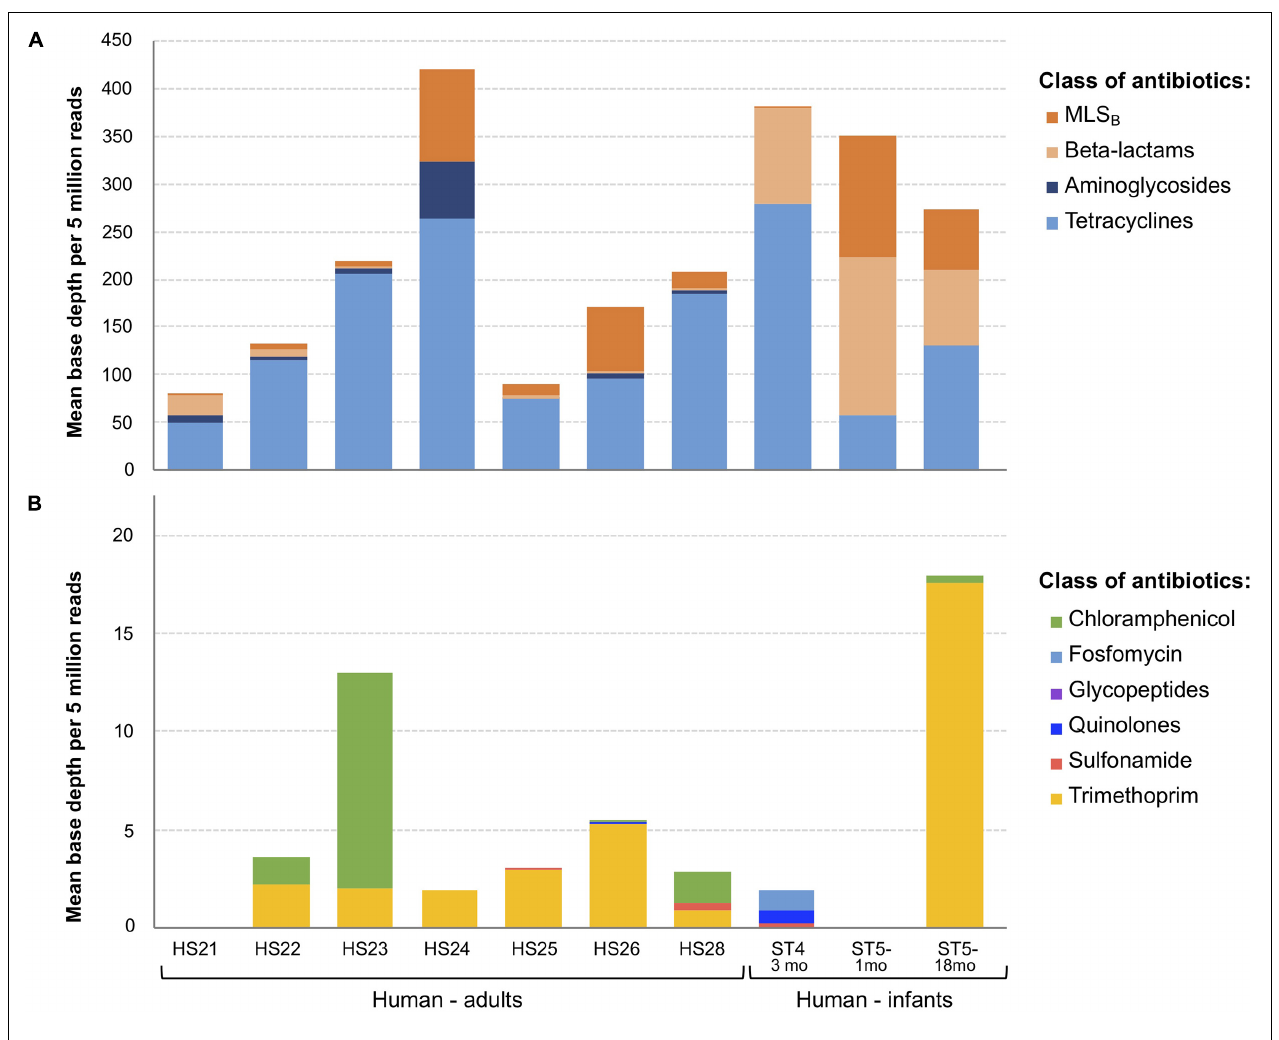
FIGURE 2 | Overview of antimicrobial resistance genes (ARGs) abundance and composition in fecal samples ( n = 10) using the shotgun metagenomics sequencing (SMS) method. (A) Major vs. (B) minor ARGs. ARGs abundance was calculated as a “mean base depth per 5 million reads” (BD5M) for each gene in each sample, and then summed for ARGs belonging to the same class of